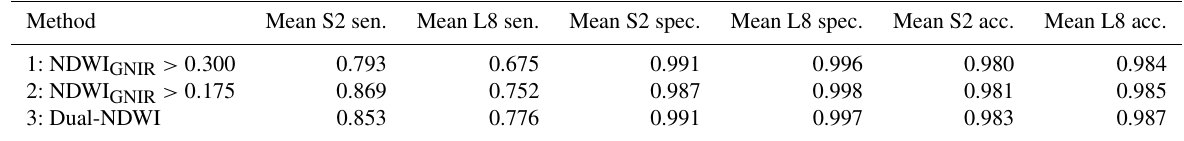
Table A1. Sensitivity (sen.), specificity (spec.) and accuracy (acc.) values averaged (mean) across three test sites: Amery, George VI and Bach ice shelves for S2 and L8 Sensors.